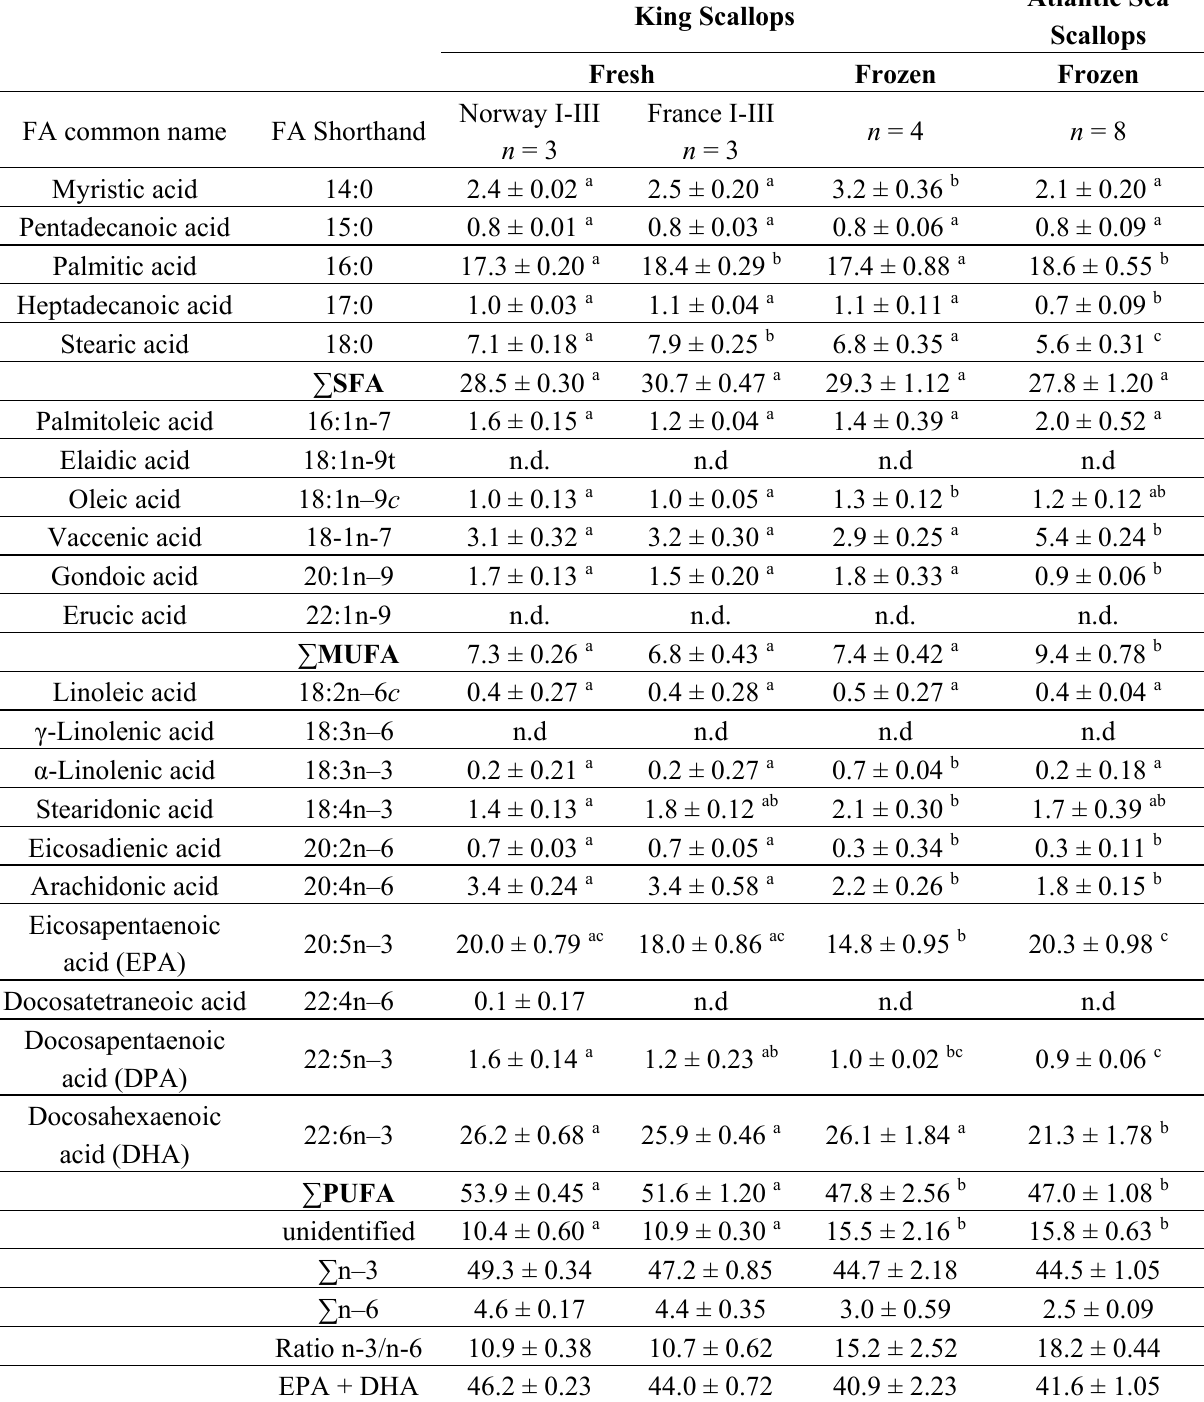
Table 2. Average composition of fatty acids (FA) of fresh king scallop meat from different harvest areas (Norway I-III and France I-III) and of frozen king scallop and Atlantic sea scallop meat products (% of fatty acids measured; SFA = saturated fatty acids; MUFA = monounsaturated fatty acids; PUFA = polyunsaturated fatty acids; n.d. = not